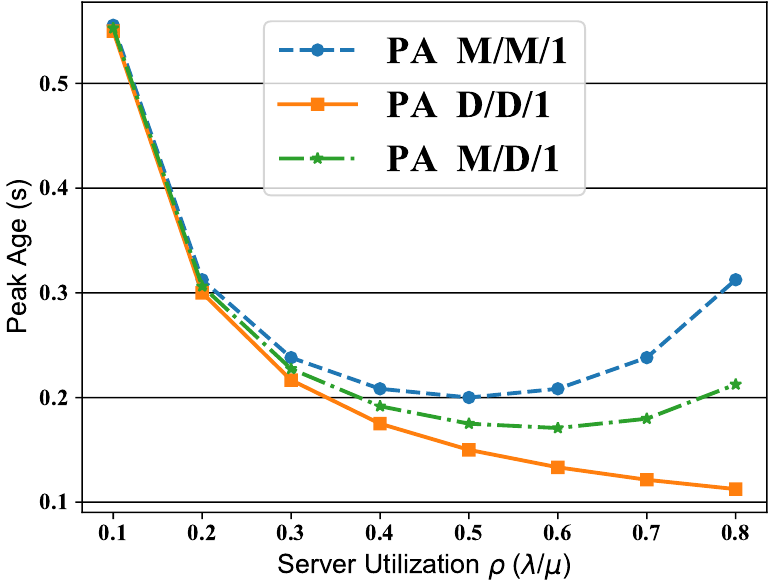
Figure 6. The PA value with respect to the server utilisation, that is, the inter-arrival rate ( λ ) divided by the service rate ( µ ). The achieved value is calculated for various queues. The queues differ in their inter-arrival time and service time distribution. The presented queues are M/M/1, which is a queue with both the inter-arrival rate and the service rate, following an exponential distribution. The D/D/1 queue has both rates to be deterministic and the M/D/1 queue has an exponential inter-arrival time and deterministic service time [49].